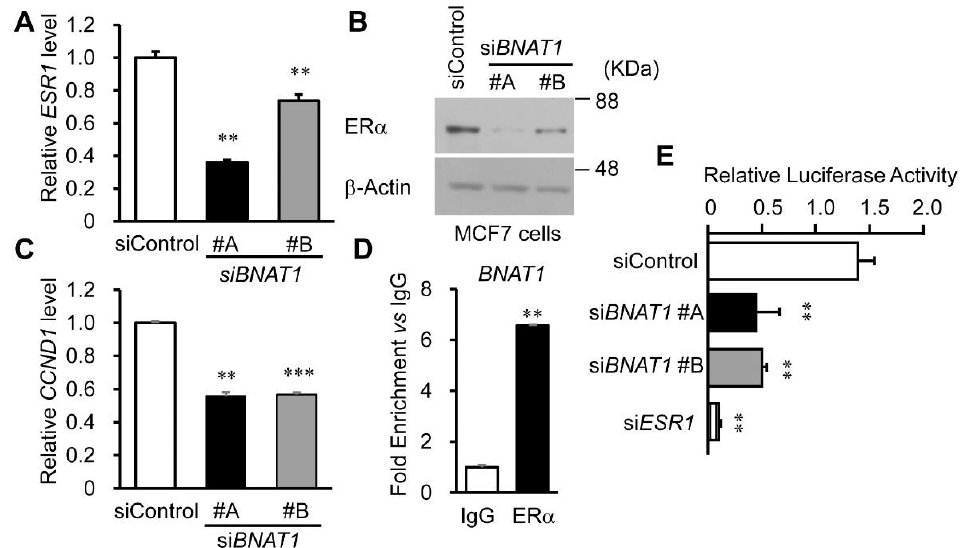
Figure 5. BNAT1 silencing attenuates ER α expression and signaling in MCF7 cells ( A ) Downregula- tion of ESR1 expression in MCF7 cells treated with si BNAT1 s. Relative RNA levels are presented as mean fold changes ± SEM versus levels for siControl ( n =3). ( B ) Immunoblotting of ER α protein in MCF7 cells treated with si BNAT1 s. ( C ) Effect of BNAT1 silencing on the CCND1 level in MCF7 cells. Relative RNA levels are presented as mean fold changes ± SEM versus levels for siControl ( n = 3). ( D ) ER α protein physically interacts with BNAT1 in MCF7 cells. RNA immunoprecipitation assay was performed using an anti-ER α antibody or a normal rabbit IgG. BNAT1 mRNA level was analyzed by qRT-PCR. The fold enrichment relative to IgG was shown as means ± SEM ( n = 3). ( E ) BNAT1 silencing suppresses E 2 (10 nM, 24 h)-dependent estrogen-responsive element (ERE)-based luciferase activity in MCF7 cells. Relative luciferase activity, determined by the normalization of Firefly luciferase value to Renilla luciferase value, are presented as mean fold changes ± SEM versus levels for siControl ( n = 3). si ESR1 , ESR1 -specific siRNA. **, p < 0.01; ***, p < 0.001.